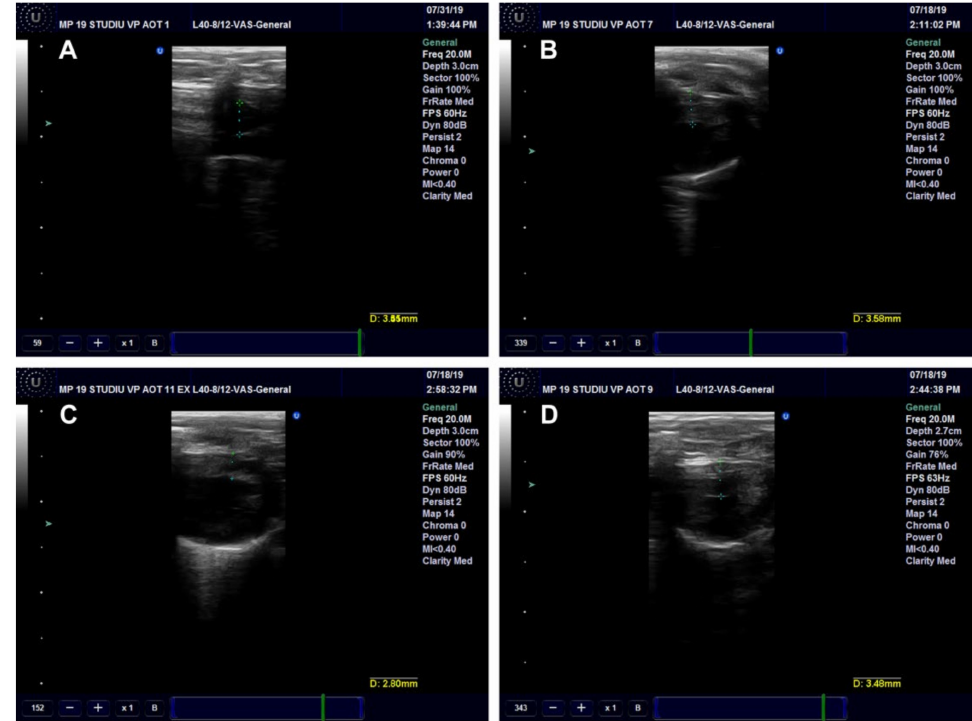
Figure 13. Left ventricle wall thickness in rats with 9 months of HFD, the last month with oral administration of: 0.9% saline solution for Control ( A ) and HFD ( B ) groups, Cornus mas L. extract for HFD + CM group ( C ) and gold nanoparticles functionalized with bioactive compounds from Cornus mas L. extract for HFD + AuNPsCM group ( D